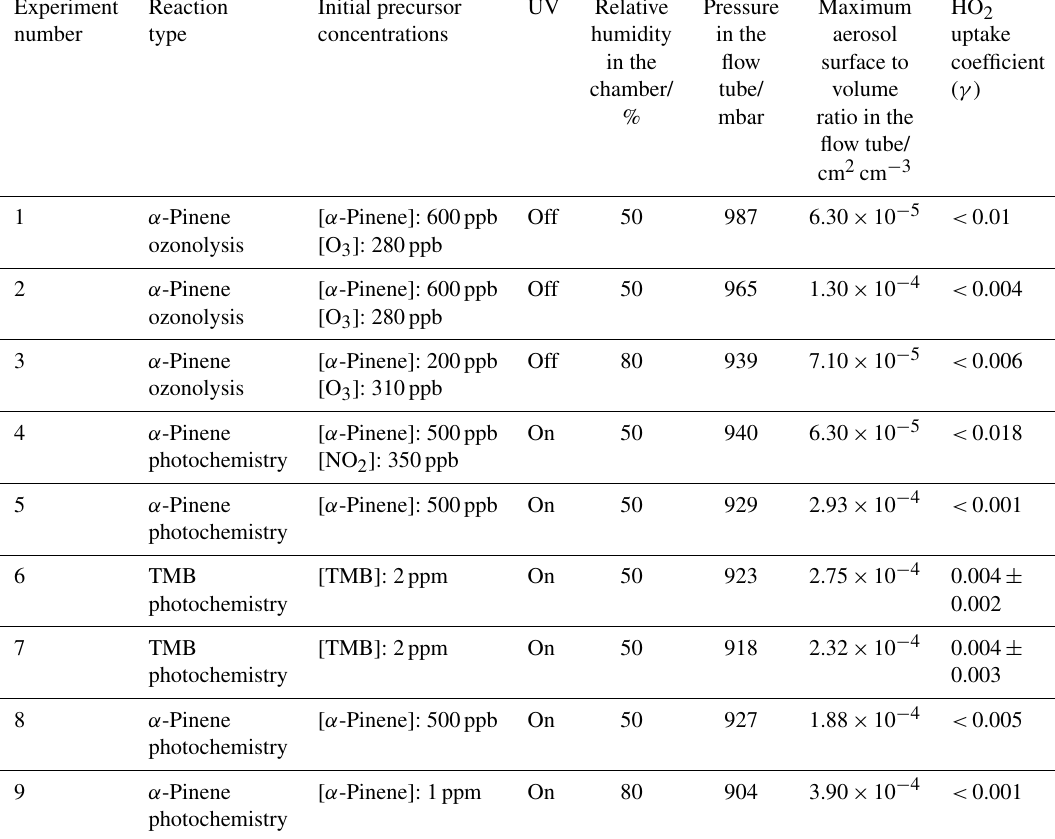
Table 2. Summary of the reactants and conditions that were utilized and the HO 2 uptake coefficients that were measured during the experi- ments. Experiments 1–4 were performed using the smog chamber, whereas experiments 5–9 utilized the PAM